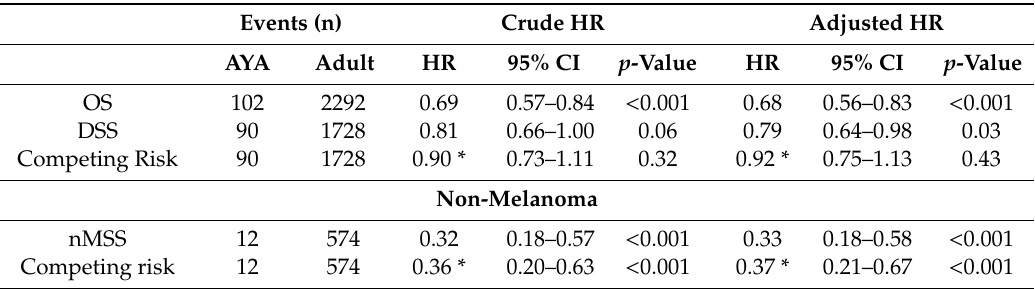
Table 3. Overall survival, disease specific survival and competing risk analyses of all advanced melanoma patients. Events (n) Crude HR Adjusted HR AYA